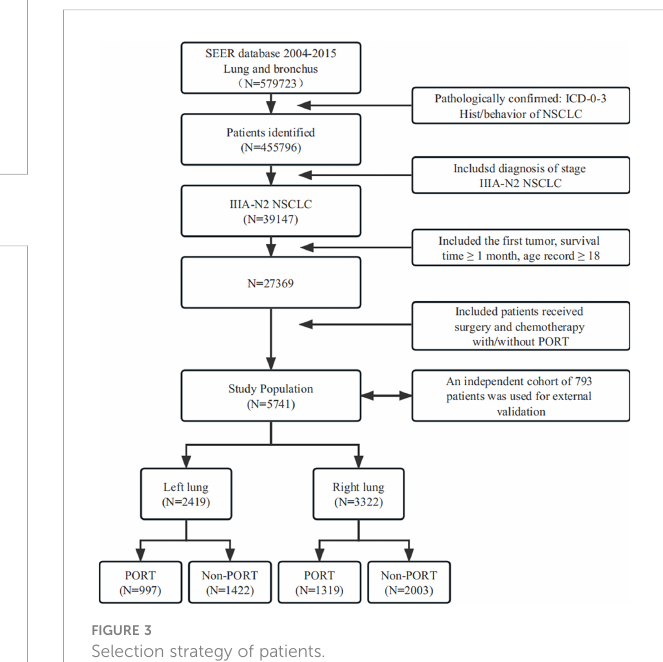
FIGURE 3 Selection strategy of